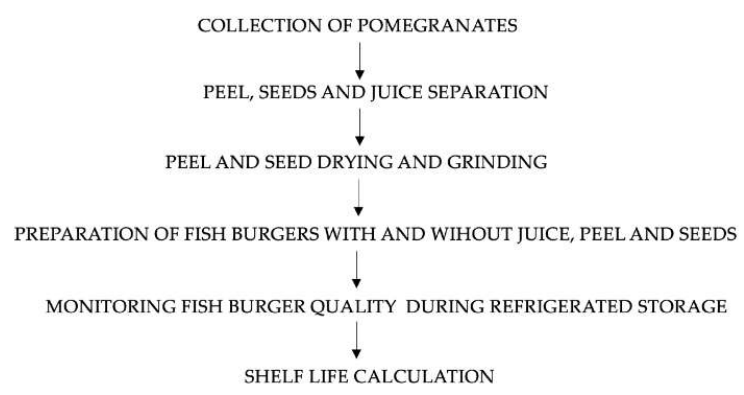
Figure 1. Schematic overview of the experimental